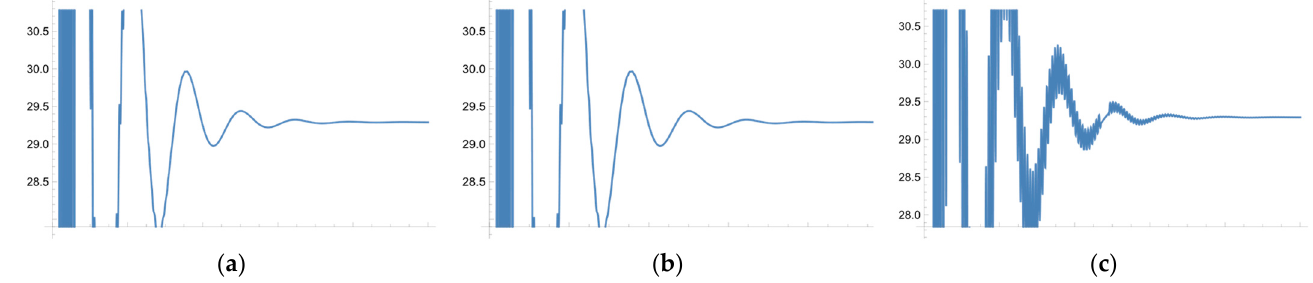
Figure 8. No. 11 state variable I lq 1 ( t ) solved from the 3 models. ( a ) Result from the proposed method, ( b ) Result from the original precise model. ( c ) Result from the traditional singular perturbation.